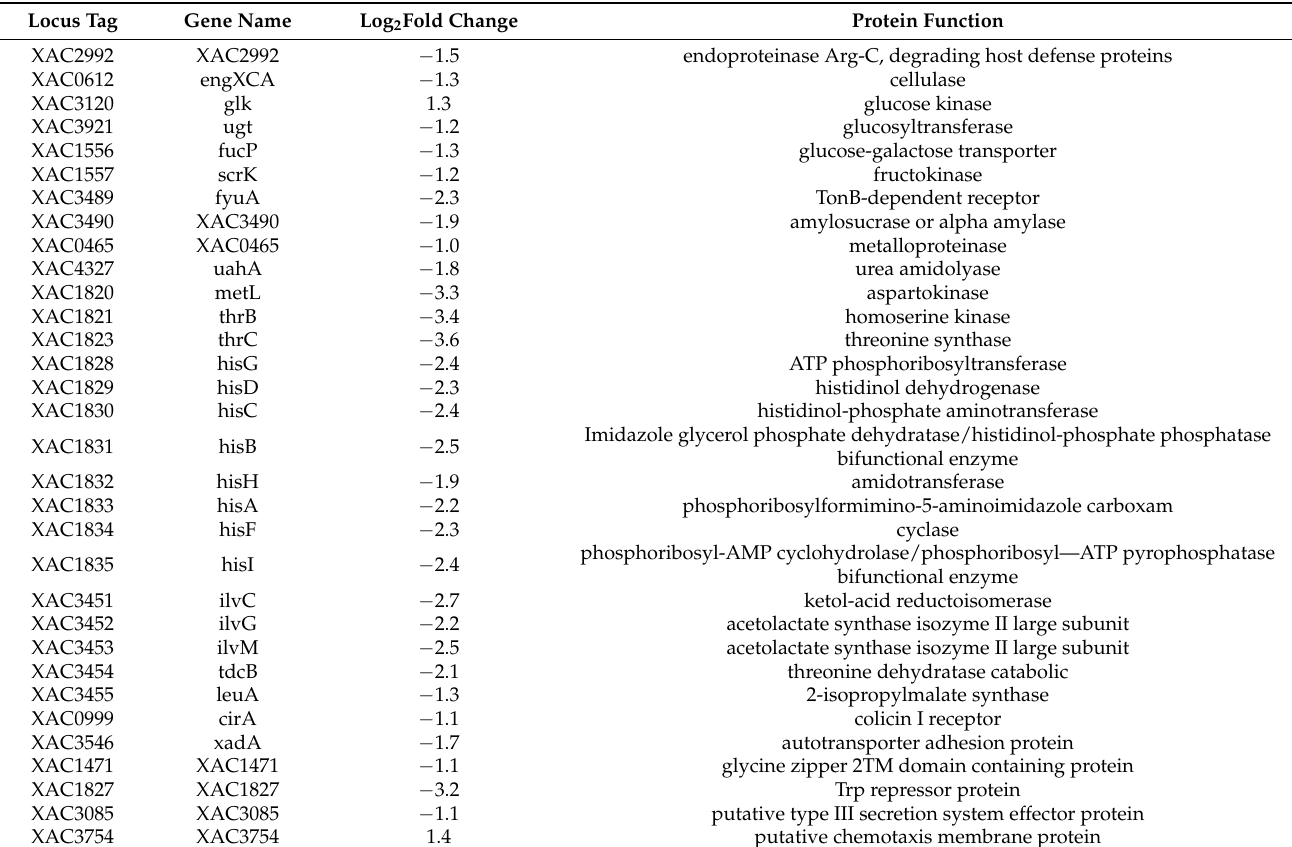
Table 1. List of genes related to quorum sensing in X. citri subsp. citri jx-6, regulated by